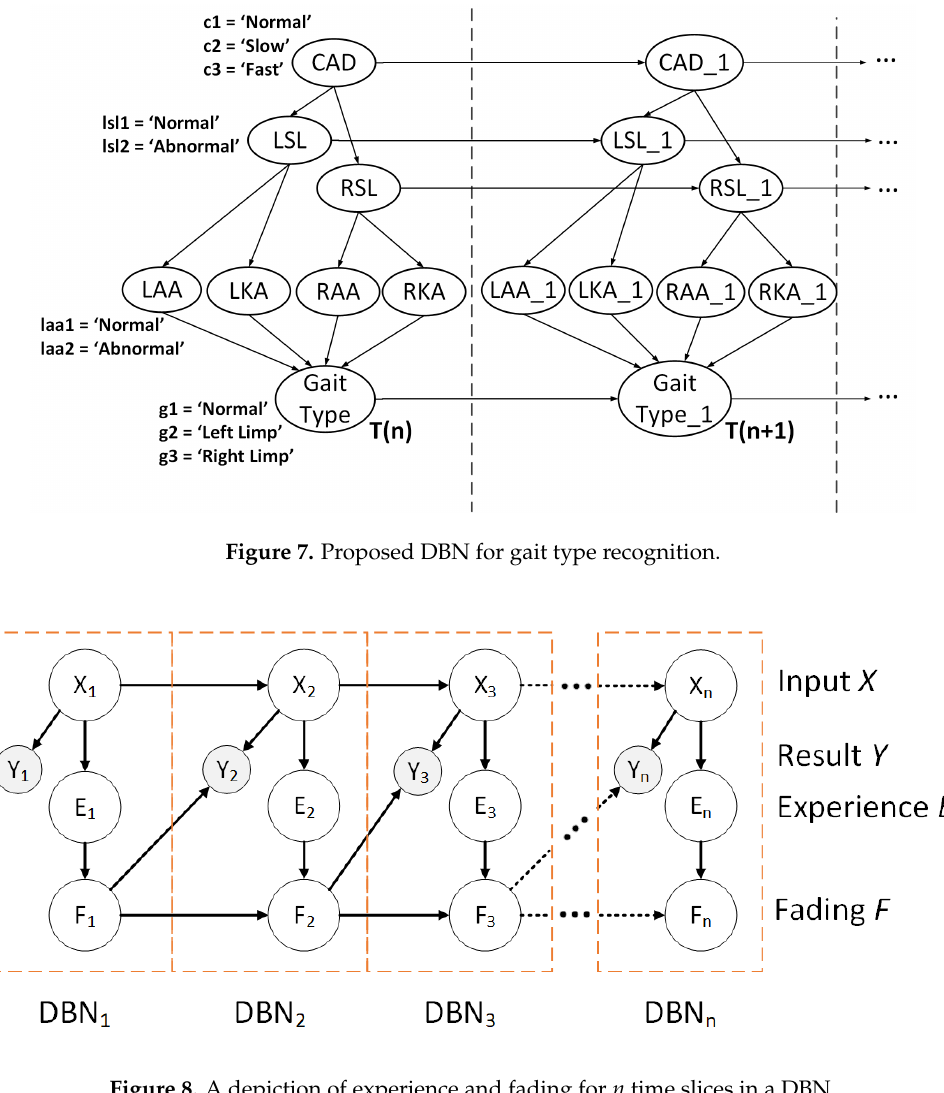
Figure 8. A depiction of experience and fading for n time slices in a